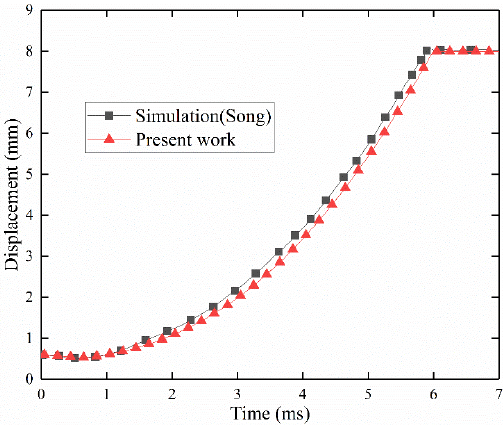
Figure 7. Displacement during the opening process with the two methods.